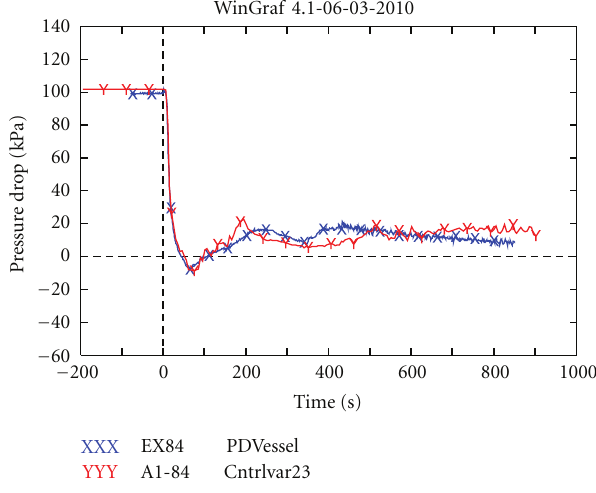
Figure 27: Vessel pressure